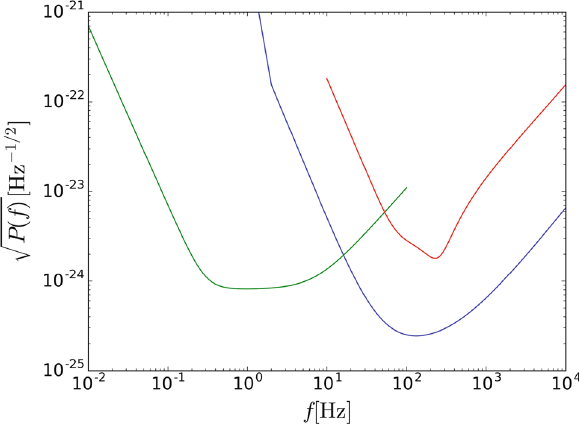
Fig. 2 The noise power spectrum. Green curve represents P 1 ( f ) for DECIGO, blue curve represents P 2 ( f ) for ET, red curve represents P 3 ( f ) for aLIGO